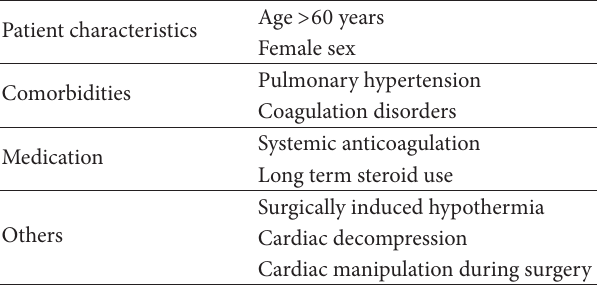
Table 1: Risk factors for pulmonary hemorrhage after Swan-Ganz catheterization